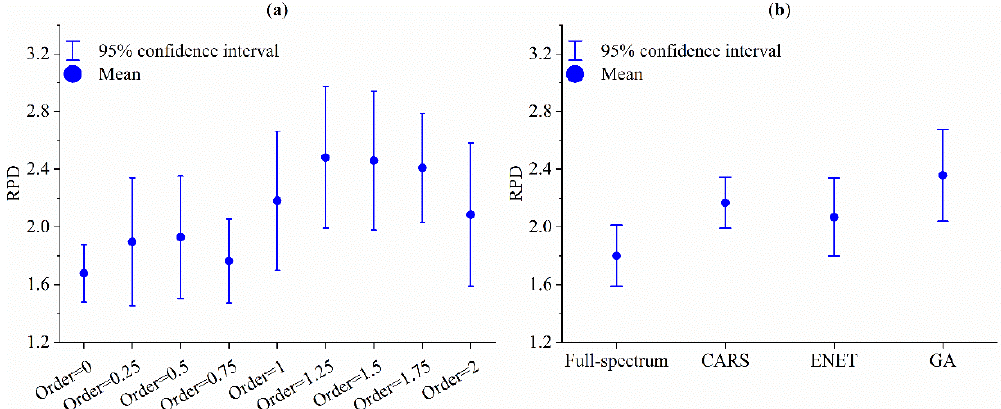
Figure 12. The mean and 95% confidence interval of ratio of the performance to deviation (RPD) values of SOM prediction: ( a ) FOD; ( b ) spectral variable selection techniques.